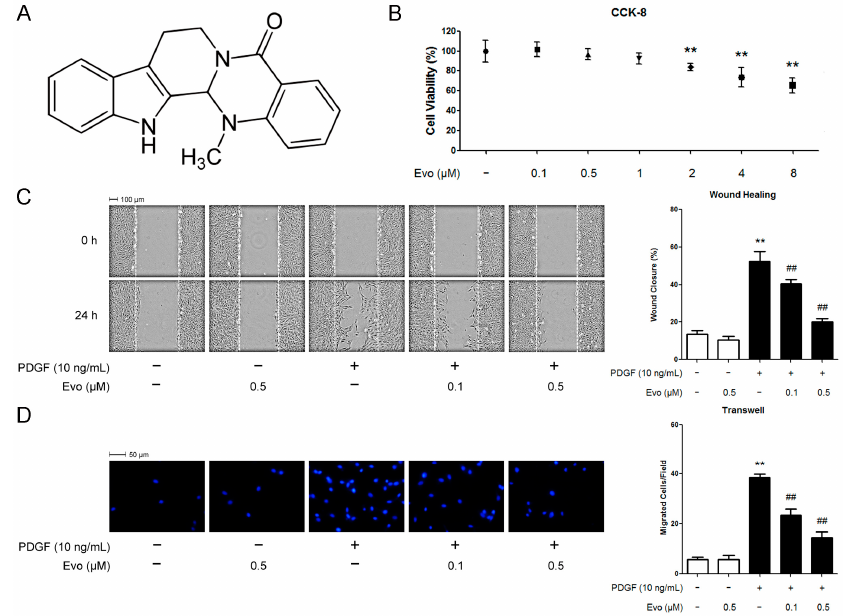
Figure 1. Evodiamine cytotoxicity test and its effect on platelet-derived growth factor (PDGF) -BB-induced vascular smooth muscle cell (VSMC) migration. ( A ) Chemical structure of evodiamine; ( B ) Cytotoxicity test using evodiamine. VSMCs were cultured in medium containing 10% fetal bovine serum, and treated with evodiamine at the indicated concentrations for 30 h. Cell viability was measured using the Cell Counting Kit-8 (CCK-8) assay. Results are expressed as cell viability relative to untreated controls; ( C , D ) Evodiamine inhibits PDGF-BB-induced VSMC migration; ( C ) Serum-starved cells were pretreated with evodiamine for 6 h before the stimulation of PDGF-BB for 24 h. Thereafter, cell migration was measured by using a wound healing assay; ( D ) Cells seeded into the inner chamber in serum-free medium were exposed to evodiamine with PDGF-BB for 6 h. Cell migration was thereafter measured by using a Boyden chamber assay. Blue color indicates cell nuclei stained with 4 1 ,6-diamidino-2-phenylindole (DAPI). Evo, evodiamine. Data are represented as mean values ˘ SD of three independently prepared samples each with five measurements. ** p < 0.01 compared with the control group; ## p < 0.01 compared with the PDGF-BB-stimulated group.